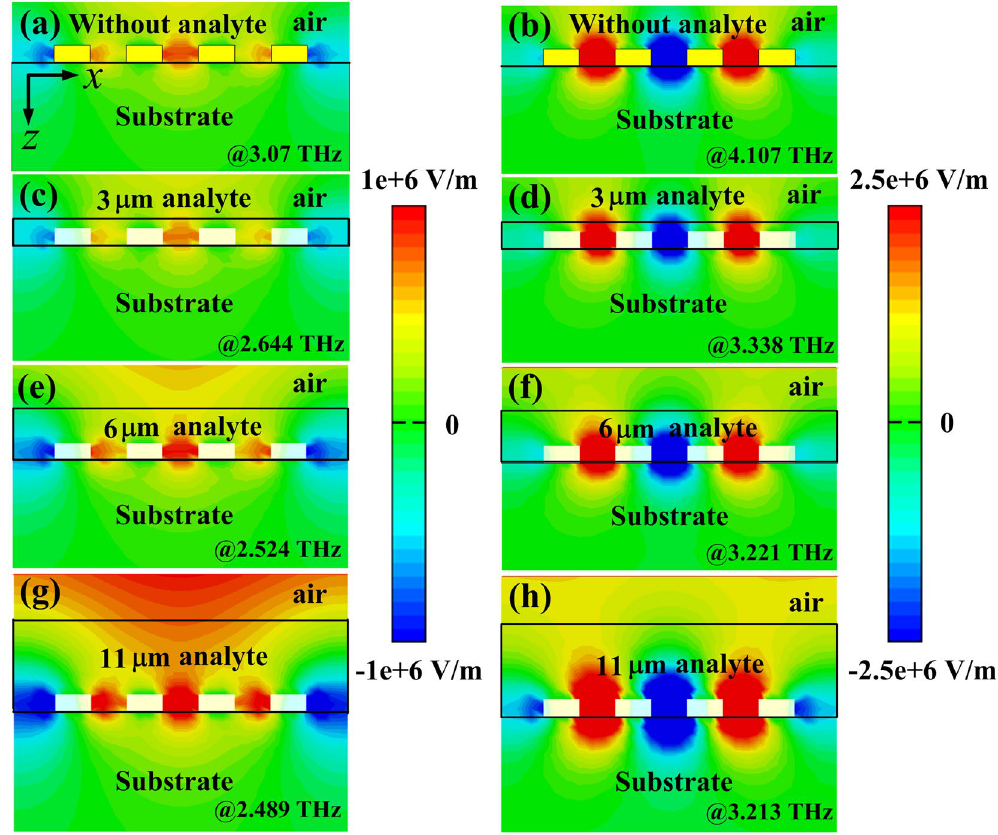
Figure 5. Electric field ( E x ) distributions at x - z plane with different analyte thicknesses. ( a , b ) 0 μ m, ( c , d ) 3 μ m, ( e , f ) 6 μ m, ( g , h ) 11 μ m, respectively. The left column is the broad resonance, and the right column is the sharp resonance.